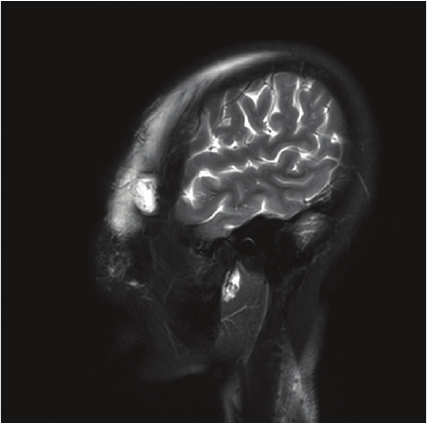
Figure 1: Coronary MR image showing PAAG migration into the cheeks and neck.